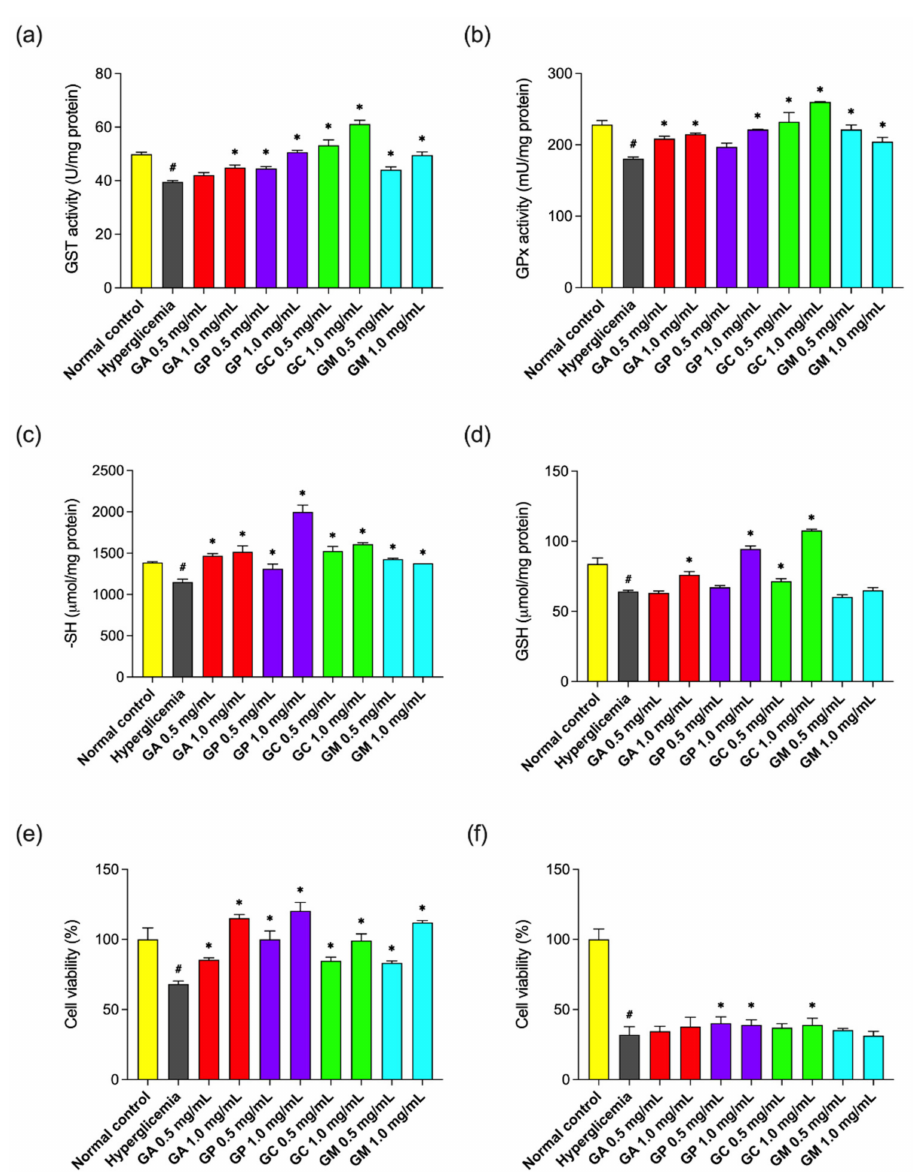
Figure 5. Effect of G. alypum ( GA ), G. punctata ( GP ), G. cordifolia ( GC ) and G. meridionalis ( GM ) methanolic leaf extracts on oxidative stress biomarkers in Hep G2 cells cultured under hyperglycemic conditions: ( a ) glutathione S-transferase (GST) activity (U/mg protein); ( b ) glutathione peroxidase (GPx) activity (mU/mg protein); ( c ) free thiol groups (-SH) content ( µ mol/mg protein); ( d ) re- duced glutathione (GSH) content ( µ mol/mg protein); ( e ) cell viability (%) assessed by the lactate dehydrogenase (LDH) assay; ( f ) cell viability (%) assessed by the 3-(4,5-dimethylthiazol-2-yl)-2,5- diphenyltetrazolium bromide (MTT) assay; Normal control: cells cultured in medium supplemented with 5.56 mM glucose; Hyperglycemia: cells cultured in medium supplemented with 20 mM glucose; # statistically significant difference in comparison to normal control ( p < 0.05); * statistically signif- icant difference in comparison to cells cultured in hyperglycemic conditions ( p < 0.05); values are means + SD ( n = 3; exceptionally, in the MTT assay, n = 8).